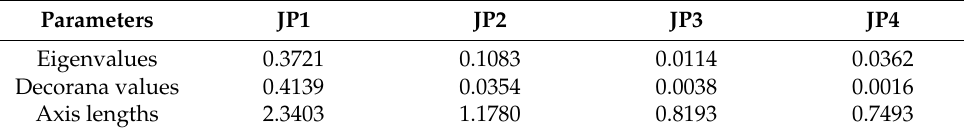
Table A1. Results of detrended correspondence